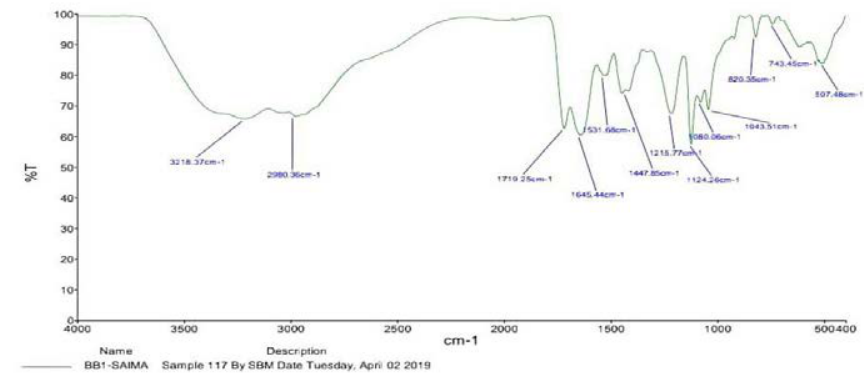
Fig. 1. FTIR of lipopeptide biosurfactant produced by the selected isolate